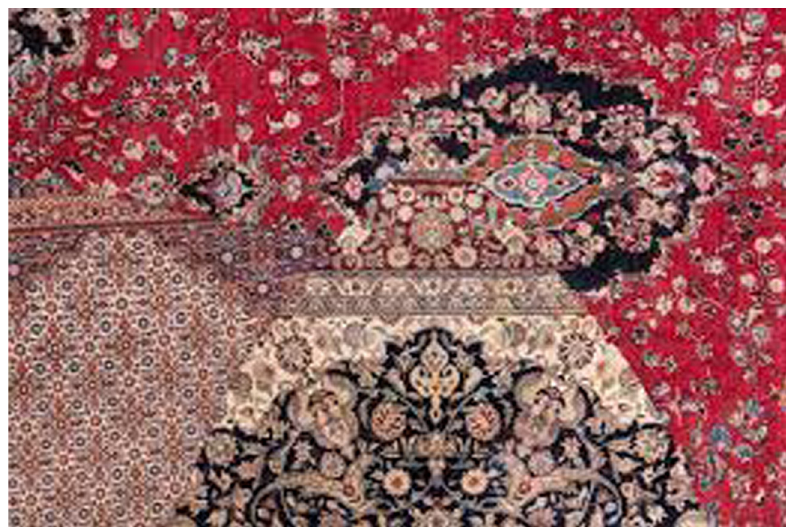
Figure 13: Leor Grady, Untitled ( Carpet ) ,